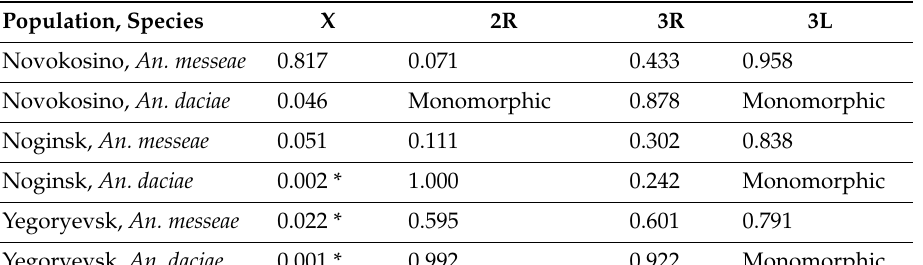
Table 2. Statistical significance ( p -values) of the deviations from Hardy-Weinberg equilibrium in the studied populations by inversion polymorphism. *—results are significant with α < 0.05 after applied Bonferroni correction.